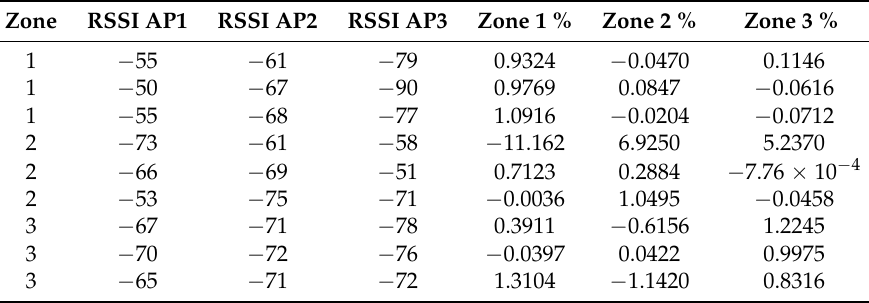
Table 12. Sample of the location evaluation, Case Study 2.